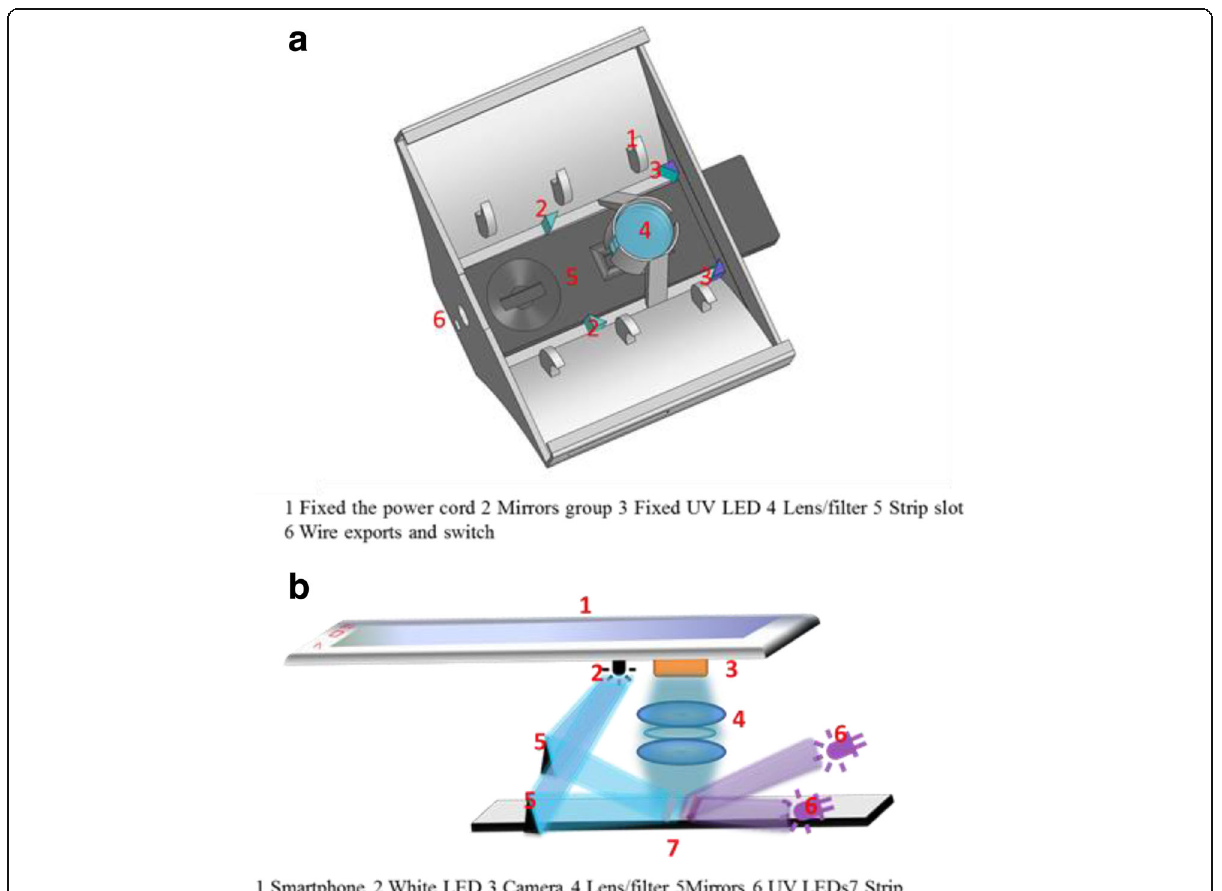
Fig. 2 a The closed shell module. b The work schematic of the smartphone detector device and schematic illustration of dual-modality imaging system. When color strips were test, the white LED turned on and the UV LED turned off. While the UV LED turned on, the fluorescent strips were to be